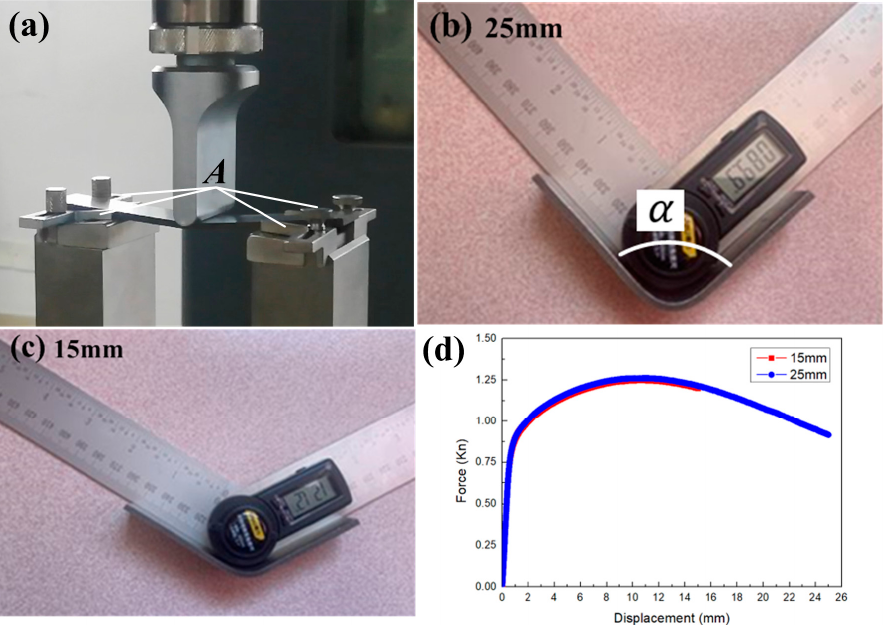
Figure 12. Three-point bending test results.